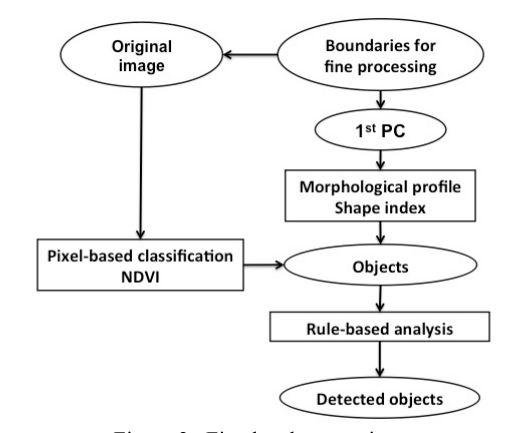
Figure 2. Fine level processing